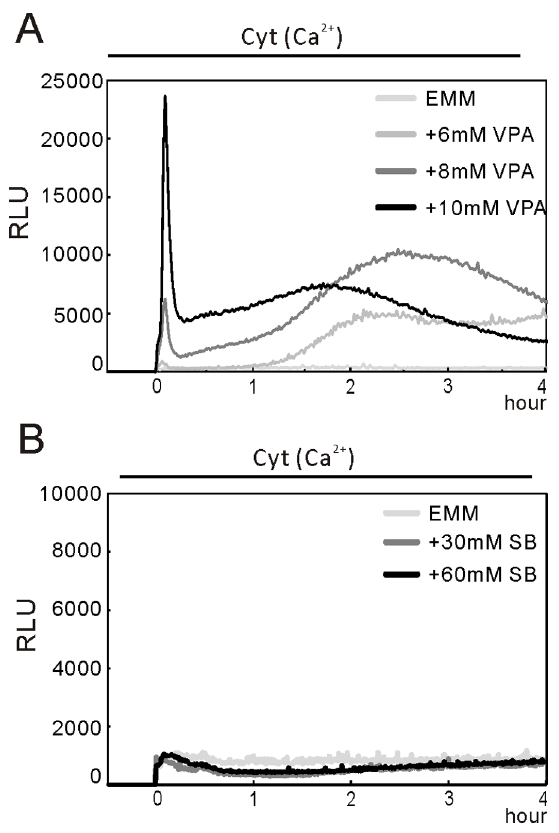
Figure 4. VPA, but not SB, caused an increase in the cytoplasmic Ca 2 + level. (A) VPA caused an increase in the cytoplasmic Ca 2 + level. The wild-type cells harboring adh1 -GFP-19- AEQ (pKB6892) were grown to exponential phase, and then the cells were collected and treated as described in Materials and Methods. A 10 m l volume of EMM or 10X stock of various concentration of VPA (A) or SB (B) was added into the 96-well plate, and the cells were delivered to the wells via the luminometer pump. The aequorin luminescence was followed for 4 hours. The luminescence, given as relative light units (RLU) s 2 1 , is plotted versus time. The data are representative of six independent experiments. (B) SB didn’t cause an increase in the cytoplasmic Ca 2 + level. The experiments were performed as